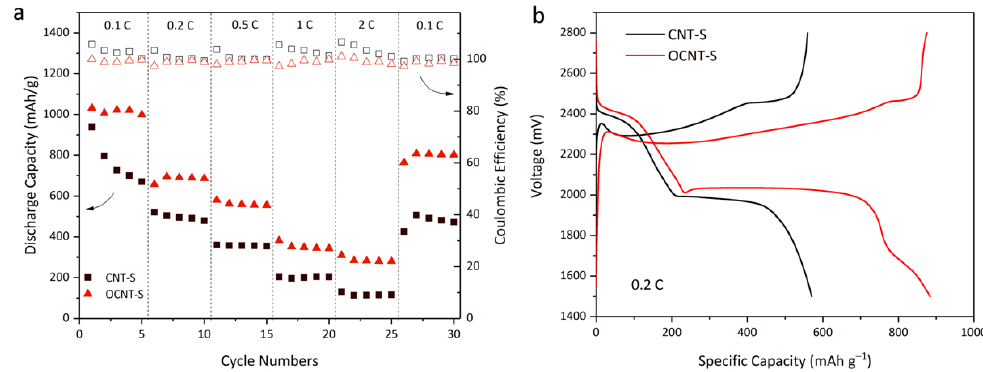
Figure 2. ( a ) Rate capability of Li-S cells with CNT-S and OCNT-S cathodes up to 2 C. ( b ) Dis- charge/charge profiles in the second cycle of Li-S cells with CNT-S and OCNT-S cathodes at a current density of 0.2 C.